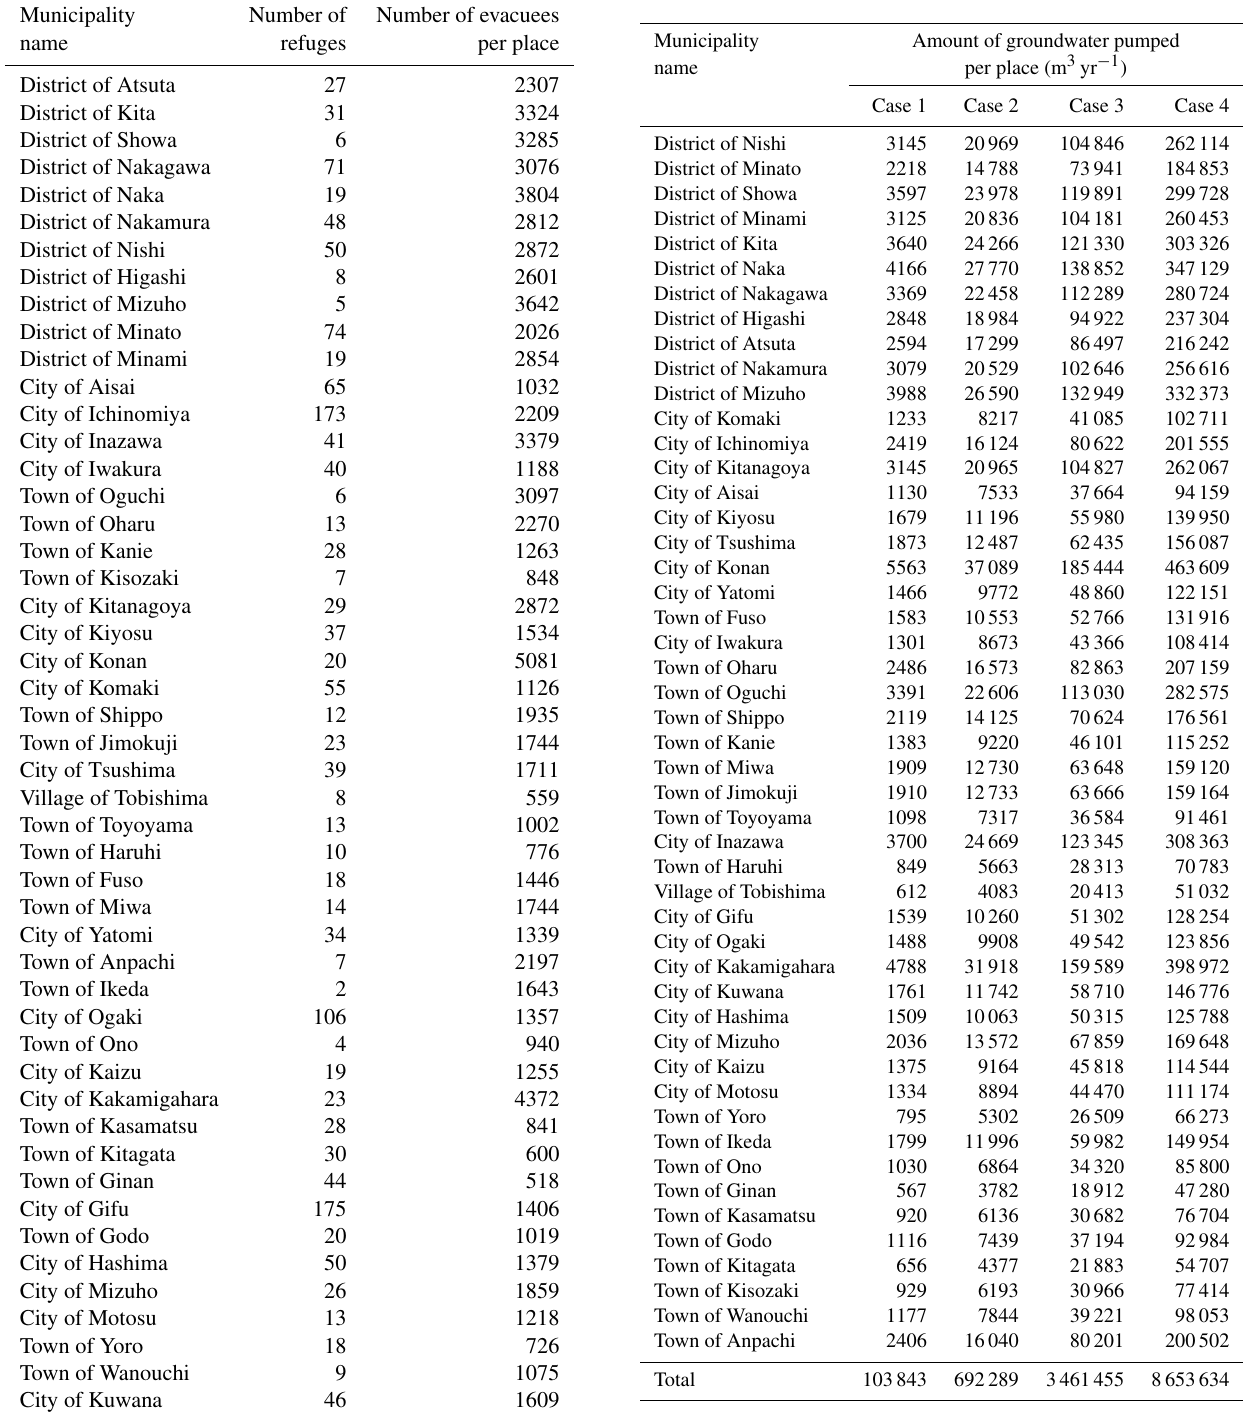
Table 1. Number of evacuees in each place. Table 2. Amount of groundwater pumped in the refuges in each